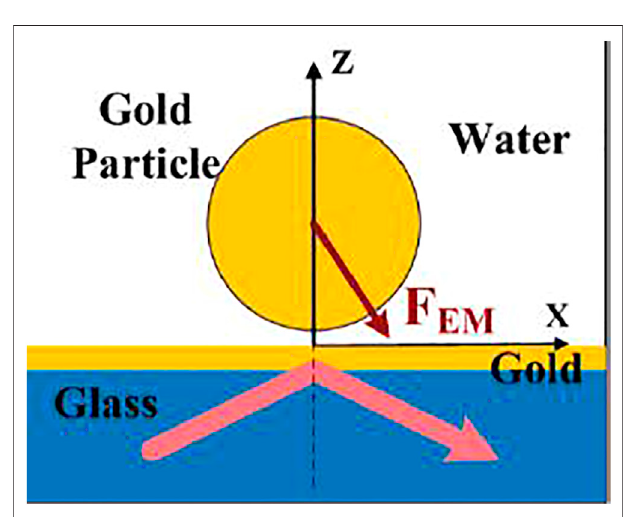
FIGURE5|(A) Opticalvorticesmanifestedinastreamlinemapoftheopticalforce fi eld.Inparticular,thisstreamlinemapdepictsthe fi eldofforces( F a polystyrene nanoparticle centred at different places in space ( y , z ) in the yz plane at x = 0. The arrows and colours represent the direction and magnitude of the optical force respectively. The dotted lines represent the physical limit of the polystyrene nanoparticle considered here with a radius of 100 nm. From this image we therefore have evidence of the presence of both contact and non-contact modes for optical trapping. The stagnation points of the non-contact modes are shown at